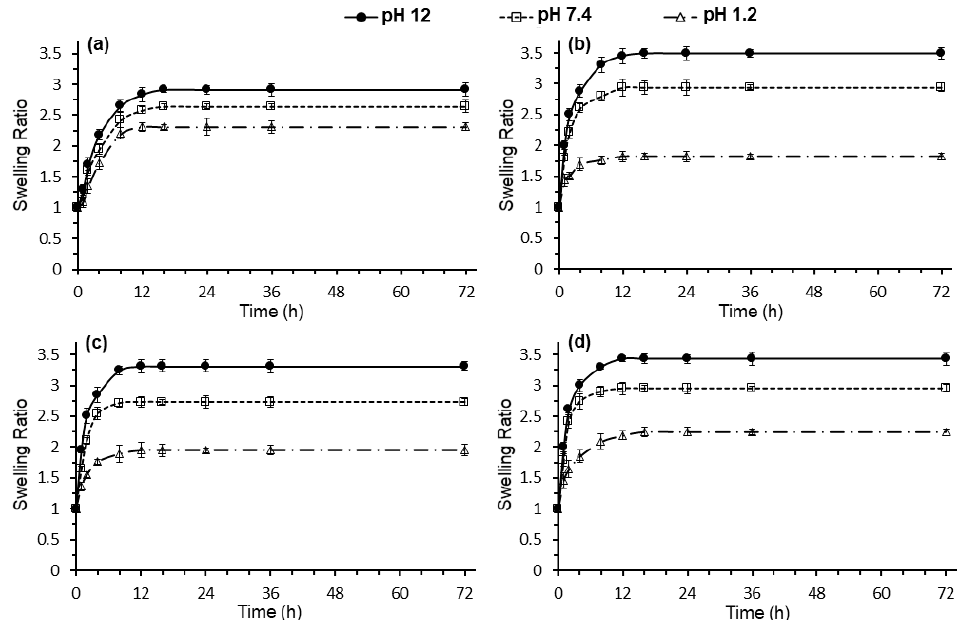
Figure 6. Swelling kinetic of ( a ) CF, ( b ) CS NPs, ( c ) CS-CF BNCs, and ( d ) CS-CF/5FU BNCs initiated from the wet state in three different media at pH 1.2, 7.4, and 12. Data is expressed as the mean ± standard deviation for triplicates within an individual experiment.